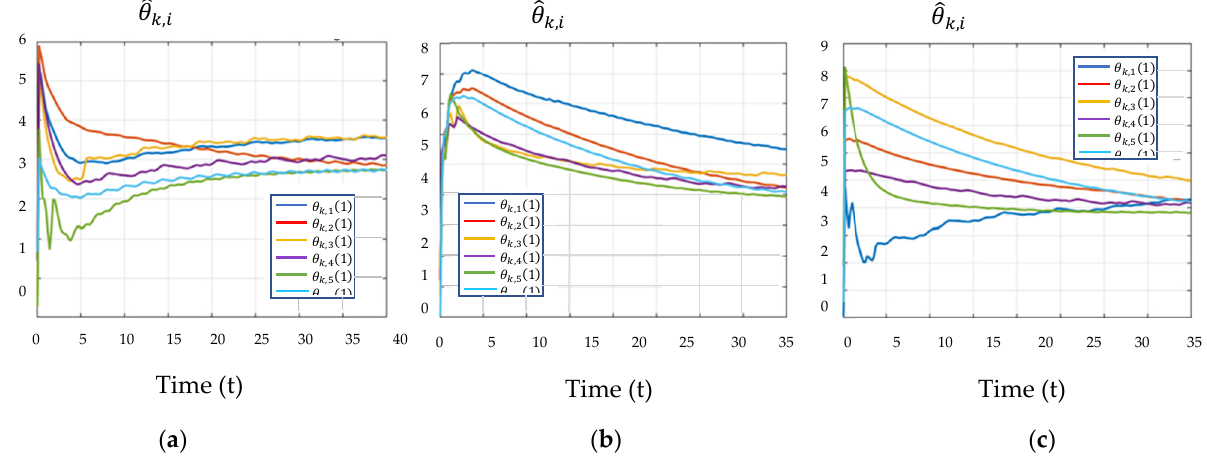
ˆ θ ( 0 ) has three different initial values. k , i when k , i